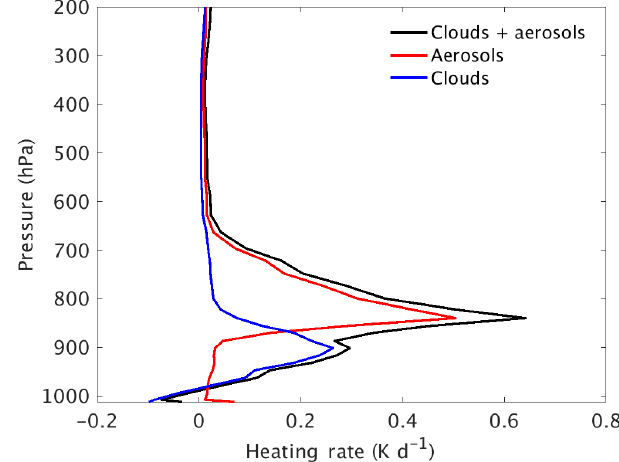
Figure 9. Monthly averaged profiles of SW heating due to aerosols, clouds, and clouds plus aerosol during August 2016 over Ascension Island.